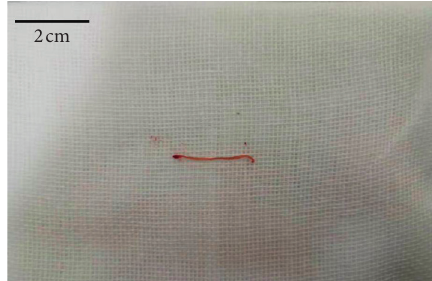
Figure 3: Biopsy specimens. The specimens were in the shape of red thin filament.